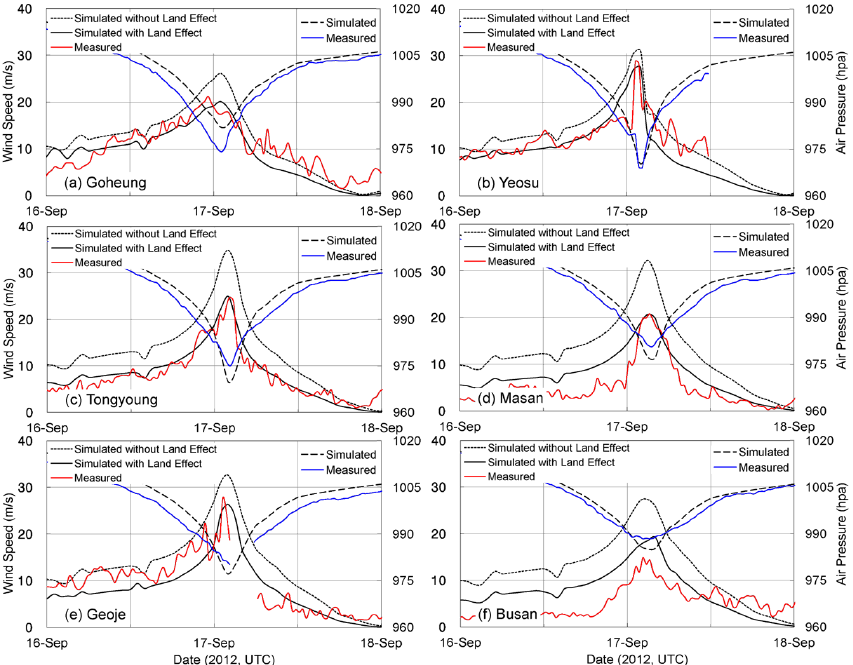
Figure 8. Comparison of wind speed (left) and air pressure (right) between the measured and simulated results during typhoon Sanba ( (a) Goheung; (b) Yeosu; (c) Tongyoung; (d) Masan; (e) Geoje; (f)